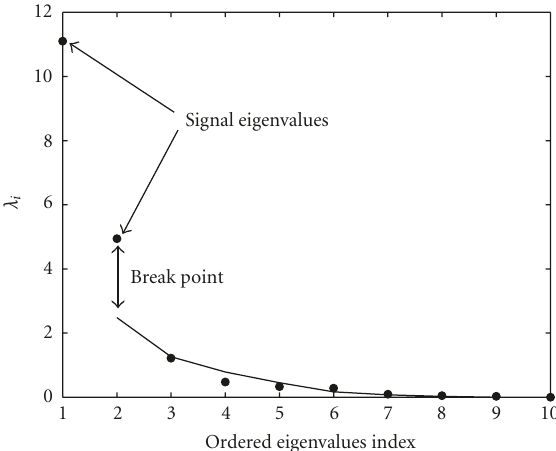
Figure 2: Profile of ordered noise eigenvalues in the presence of 2 sources, and 10 sensors. The ordered profile of the observed eigen- value is seen to break from the noise eigenvalue distribution, when there are sources